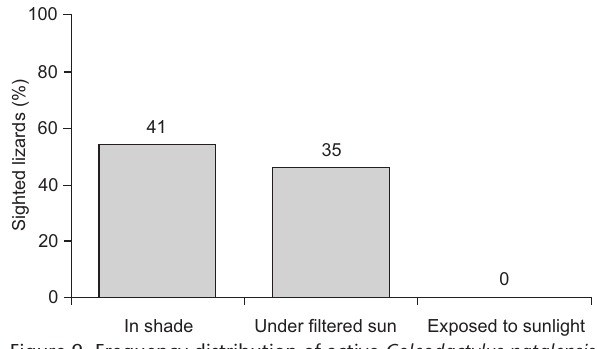
Figure 9. Frequency distribution of active Coleodactylus natalensis (n = 76) under different sunlight exposure conditions in Mata da Pipa State Park, Tibau do Sul, Rio Grande do Norte, Brazil. Num- bers on top of bars indicate sample